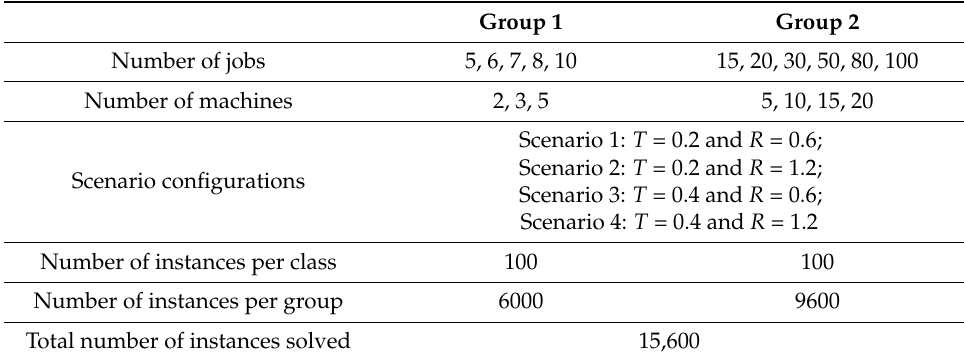
Table 3. Parameters for generation of the